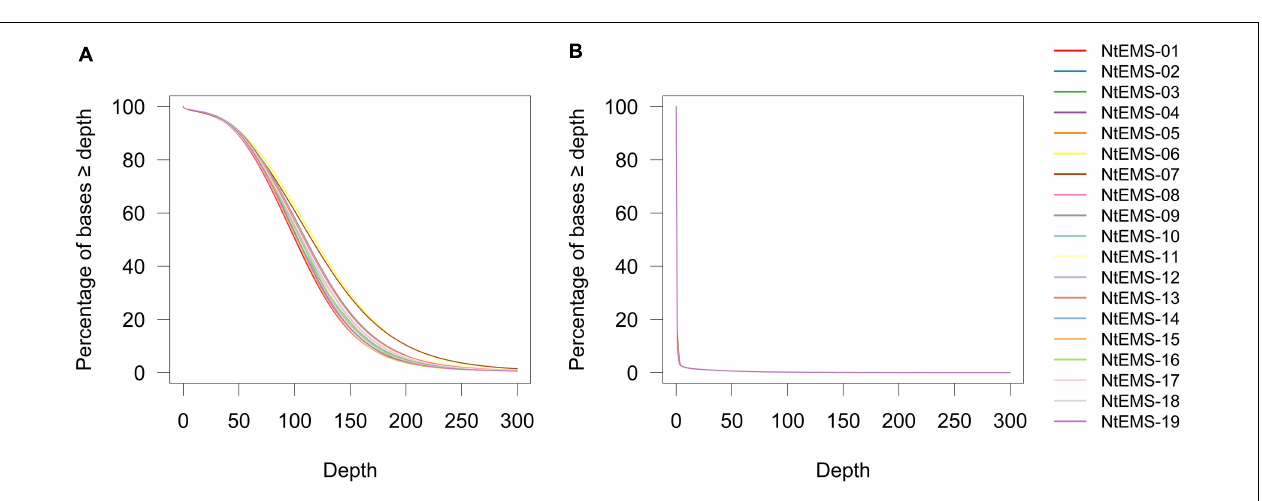
FIGURE 2 | Coverage of 160 × whole-exome sequencing in the target coding regions (A) and non-target regions (B) . Read depths is shown on the x